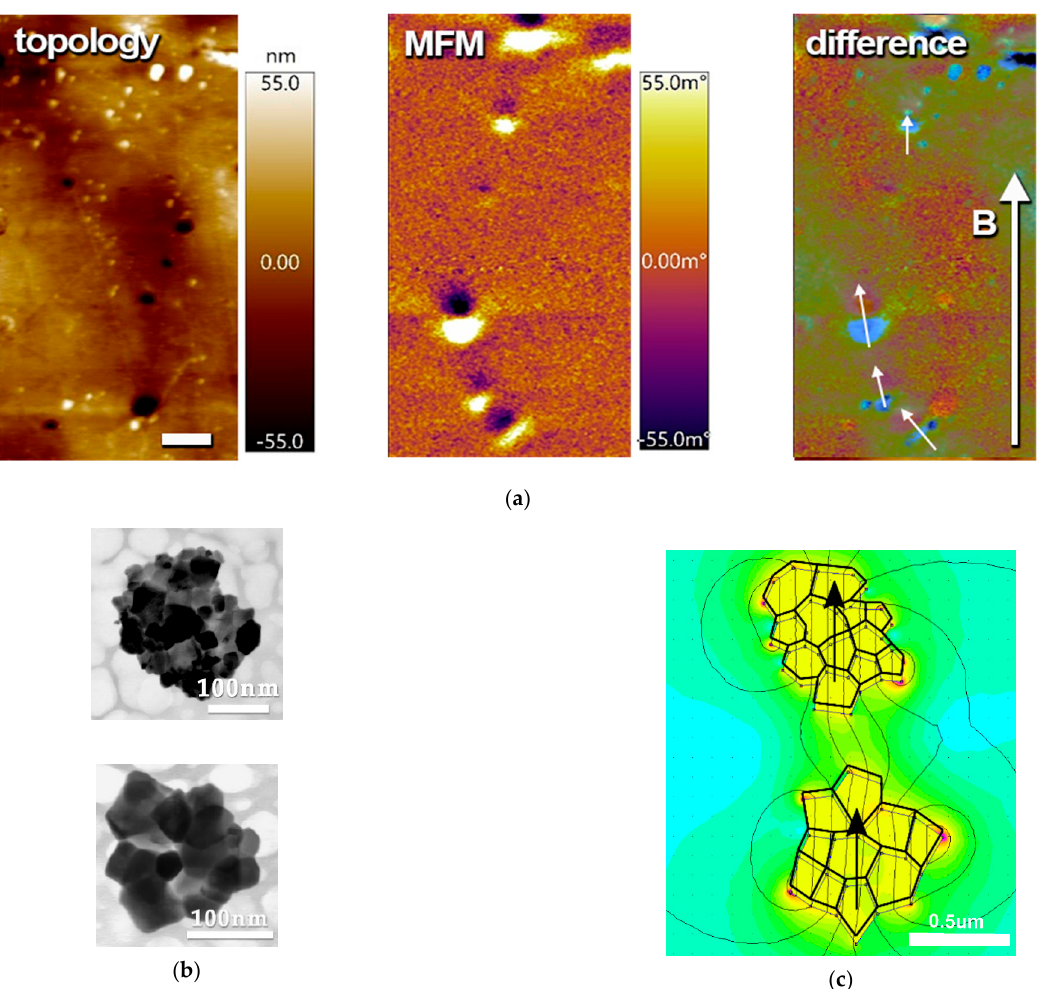
Figure 6. ( a ) Magnetic force microscopy (MFM) images of PVDF-TrFE/CFO nanocomposite: topology, MFM signals, and their difference. Arrow B indicates the direction of the applied magnetic field during polymerization. Scale bar is 2 μ m; ( b ) TEM image of separated aggregates of powder CFO NPs; ( c ) illustration of a possible configuration of two aggregates and simulated magnetic field distribution for this configuration.